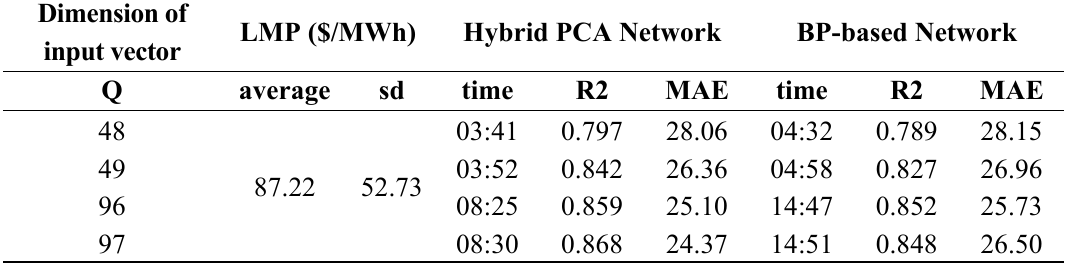
Table 6. Performance comparison between the proposed hybrid PCA and BP-based neural network (Byberry, summer).